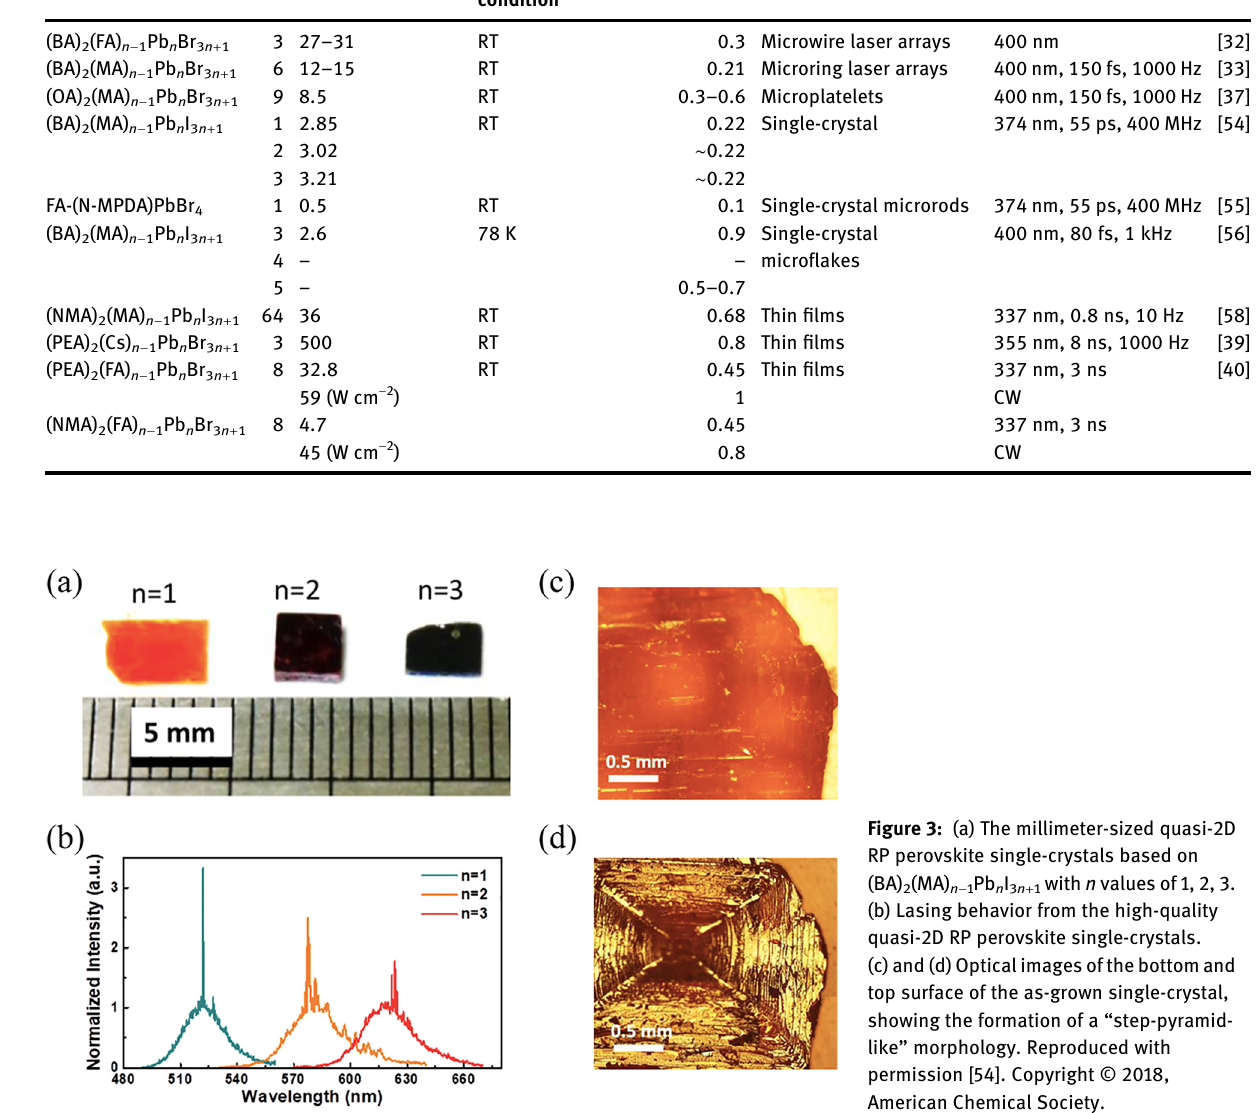
Table  : Summary of the key parameters for quasi-  D perovskites-based optical pumping lasers. Quasi-  D perovskite